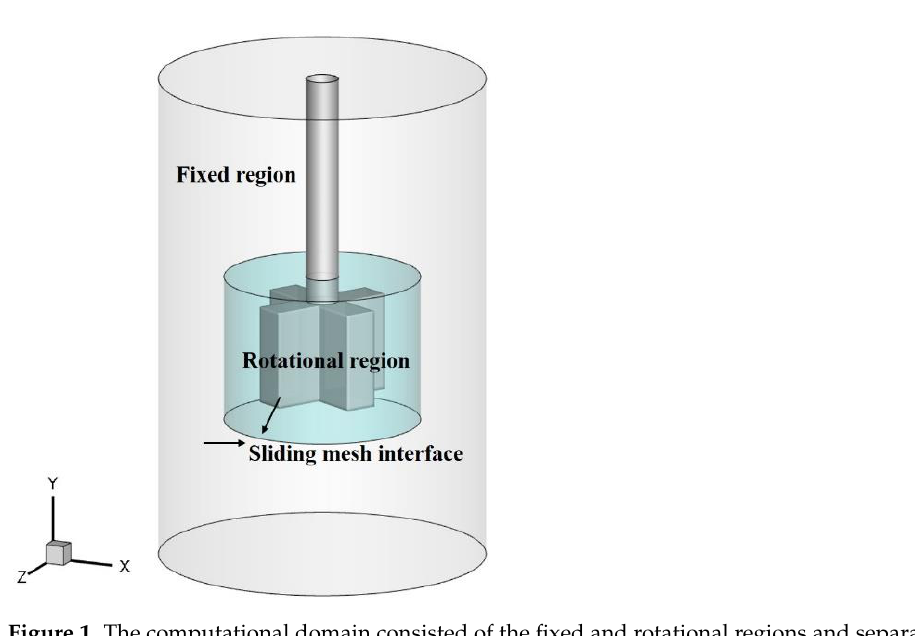
Figure 1. The computational domain consisted of the fixed and rotational regions and separated the sliding mesh interface. sliding mesh